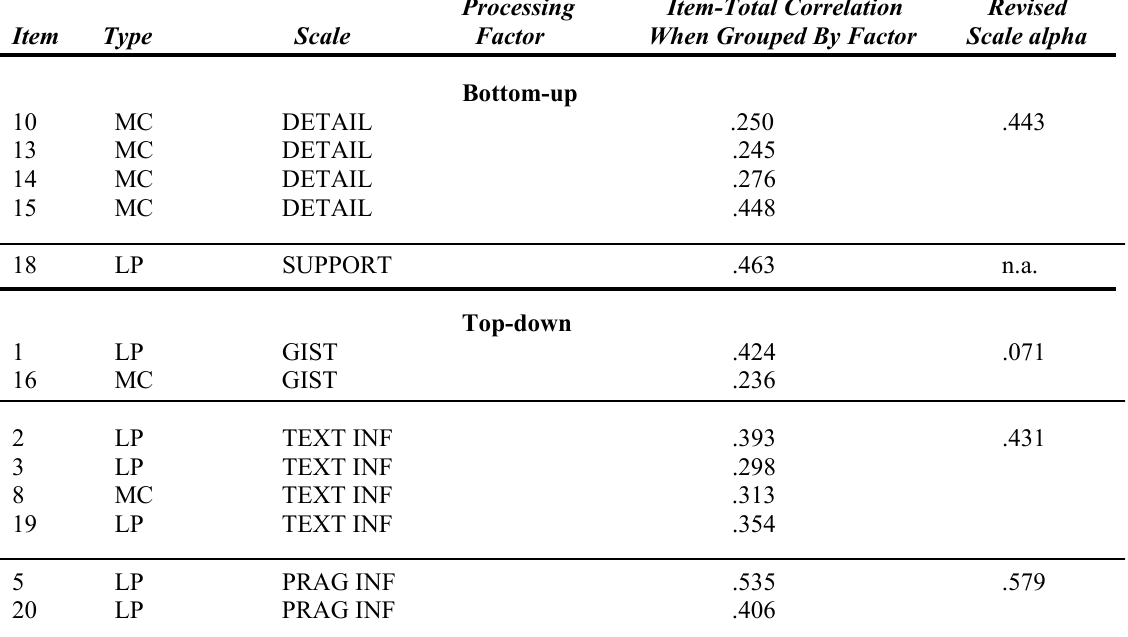
Revised Reliability Analysis of Each of the Scales and Factors (13 Items) Processing Item-Total Correlation